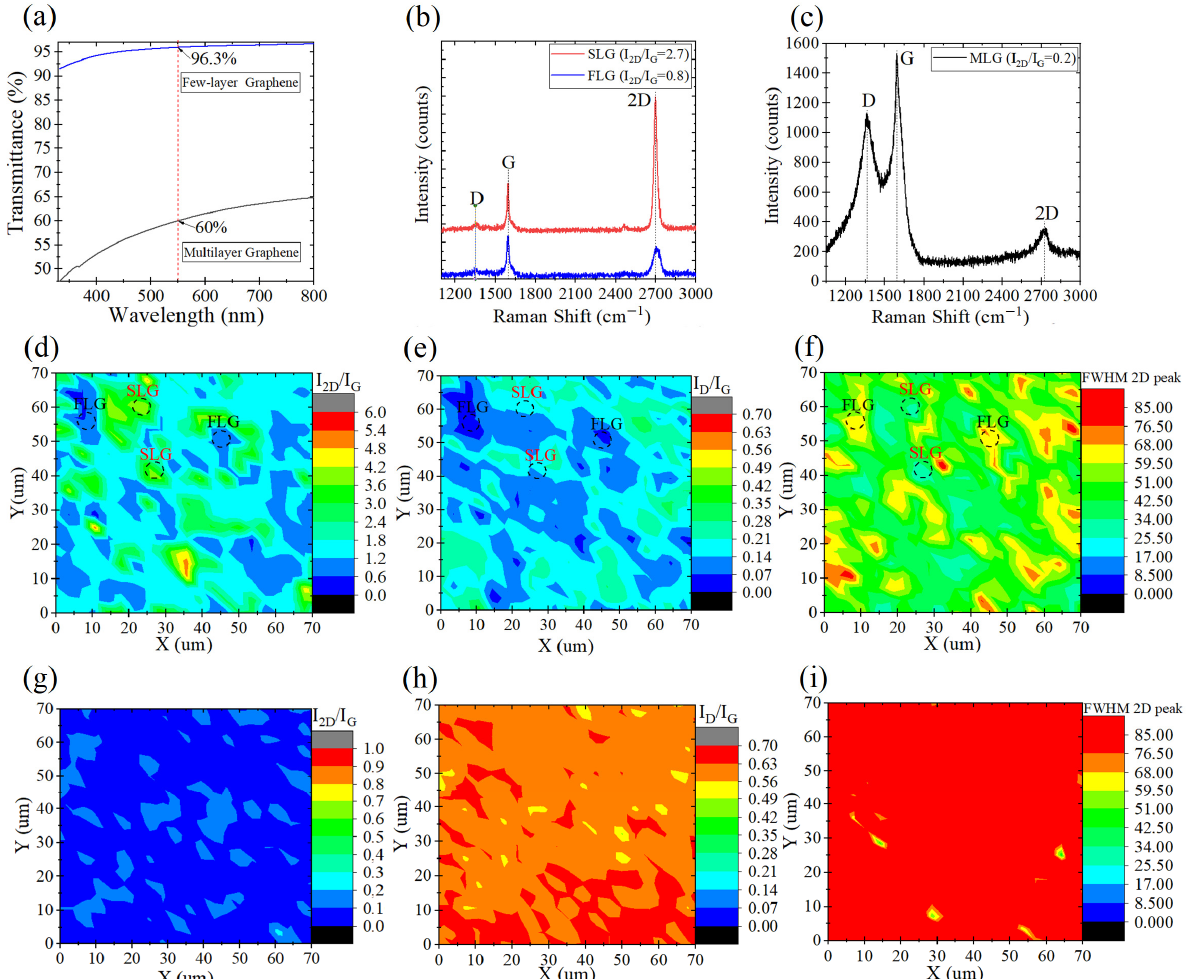
Figure 3. ( a ) The transmittance coefficient of graphene samples transferred on a SiO2/Si substrate as a function of light wavelength. Raman spectra ( b , c ), Raman maps of I2D/IG ( d , g ), ID/IG ( e , h ) ratios and 2D peak FWHM ( f , i ) from random areas on the continuous FLG ( b , d – f ) and MLG ( c , g – i ) transferred to a SiO2/Si substrate acquired at a laser excitation wavelength of 532 nm.